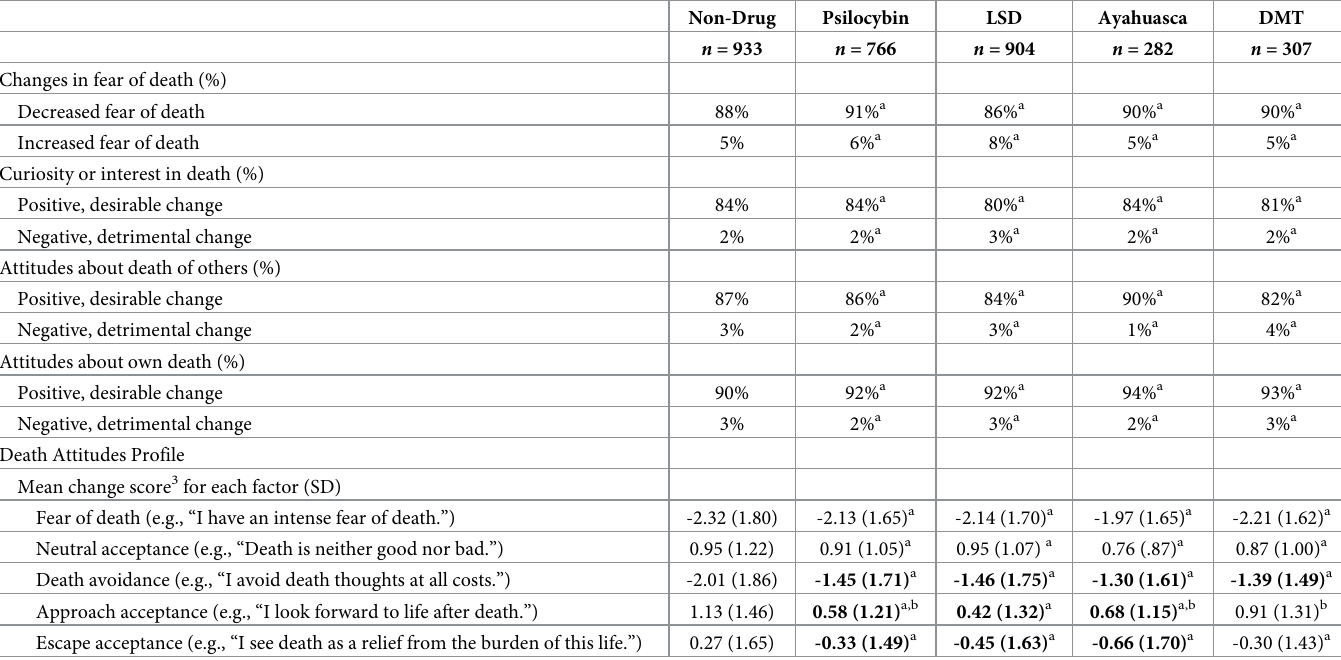
Table 8. Changes in death attitudes attributed to the experience among the Non-Drug, Psilocybin, LSD, Ayahuasca, and DMT groups 1,2 .